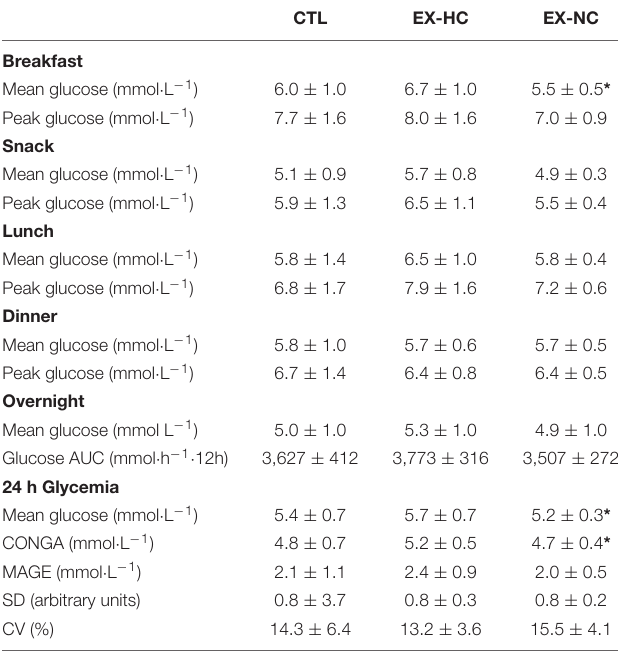
TABLE 3 | Analysis of CGM-derived glycemic outcomes. CTL EX-HC